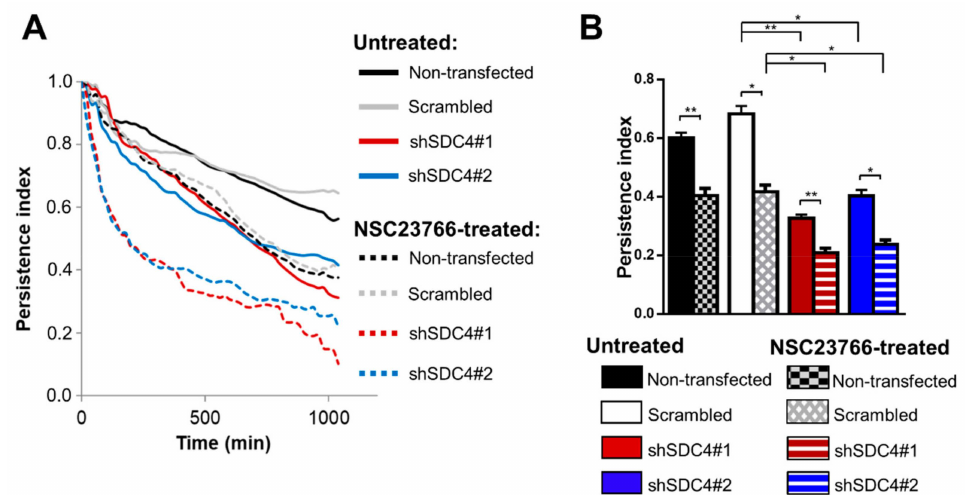
Figure3. Directionalpersistenceincellmigration. ( A )Averagepersistenceindex(vectorialdistance / total path ratio) over elapsed time indi ff erent cell lines. ( B ) E ff ect of Syndecan-4 (SDC4) silencing and / or